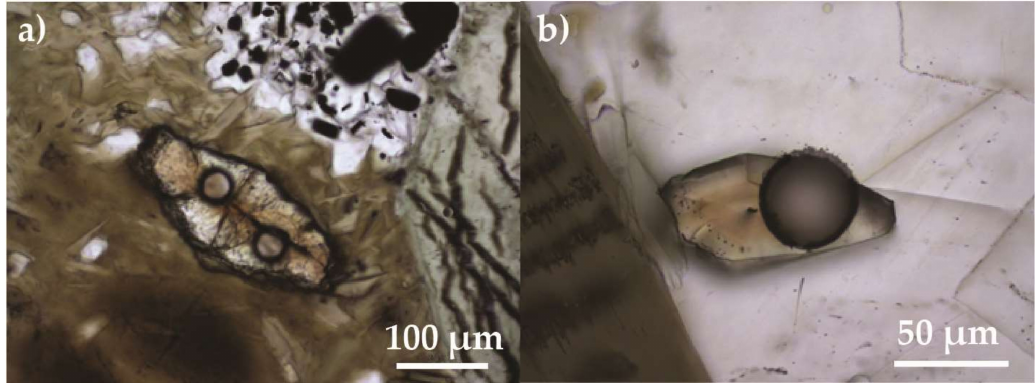
Figure 14. ( a ) Plane polarized light photomicrograph of lamprophyre sample displaying a titanite crystal within a chloritized biotite lath. The circular features in the center of the titanite crystals are ablation pits (sample 80-12). ( b ) Plane polarized light photomicrograph of lamprophyre sample displaying a titanite crystal within a carbonate grain. The circular feature is the ablation pit (sample